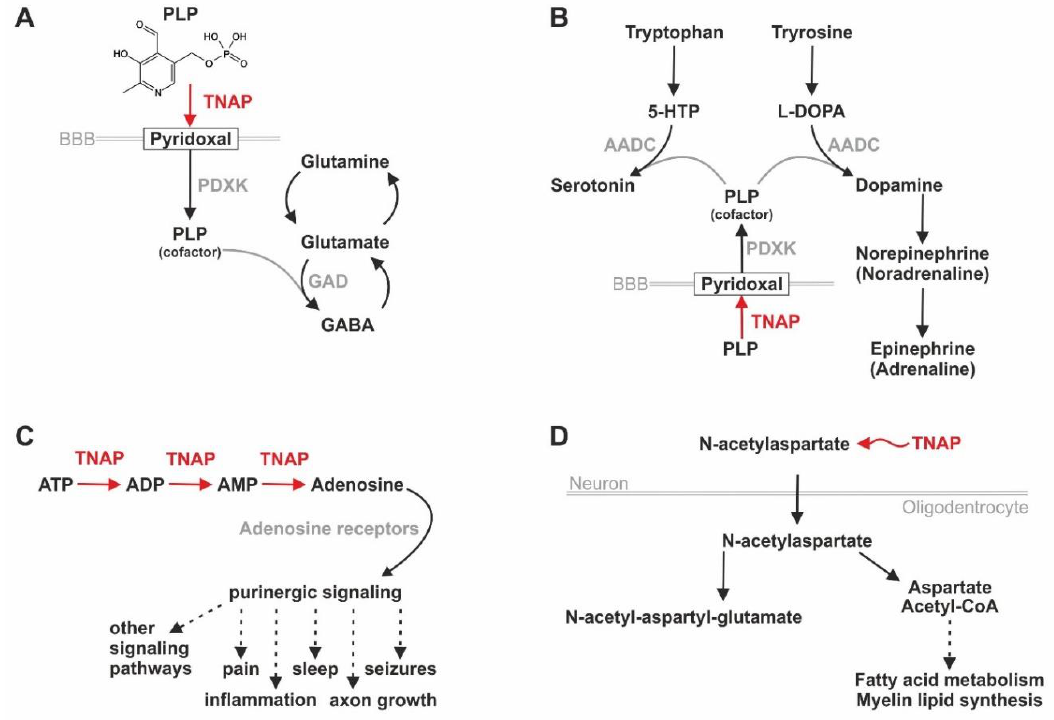
Figure 4. TNAP function is linked to PLP/cofactor, neurotrophic factor and myelin synthesis. ( A ) TNAP’s influence on the GABA synthesis. ( B ) TNAP’s role in the catecholamine and serotonin